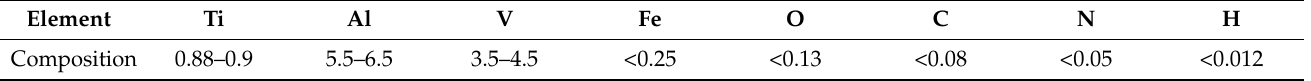
Figure 10. Plot of π 0 (dependent) vs. π 1 (independent) dimensionless numbers calculated using experimental data collected during the fabrication of Ti6Al4V metallic via SLM [60]. Table 11. Chemical composition, reported by the supplier [61], of Ti6Al4V powder used in [60]. Element Ti